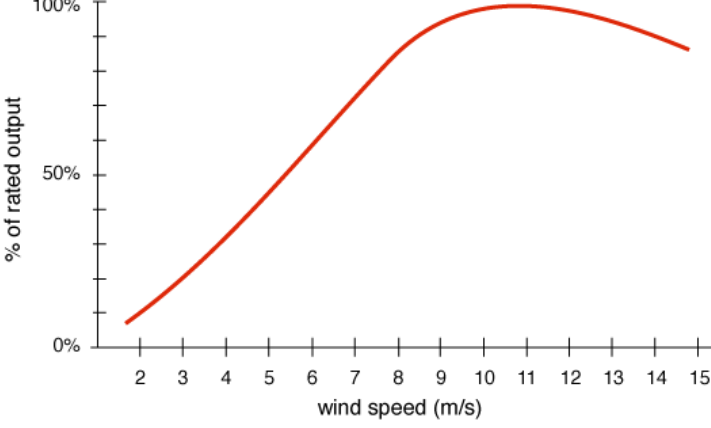
Figure 3. Typical curve of a wind power system [14].